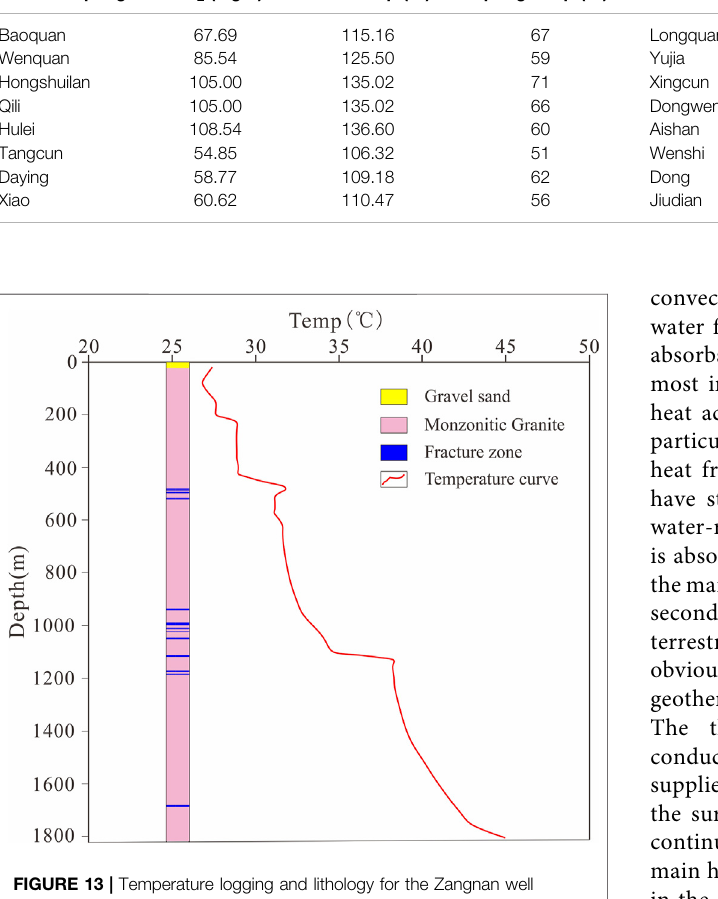
TABLE 3 | Characteristics of the geothermal reservoir in the Jiaodong Peninsula. Name of spring